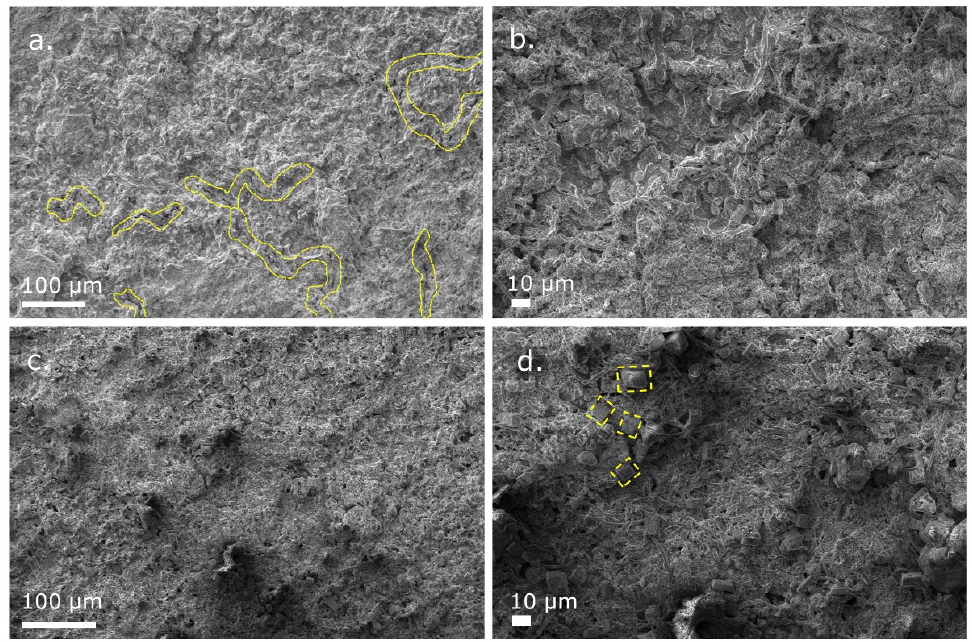
Figure 5. SEM micrographs of disassembled WS 2 /SiOC electrodes from ( a ) NIB half-cell; ( b ) NIB half-cell with a magnified view; ( c ) KIB half-cell; ( d ) KIB half-cell with a magnified view after 50 electrochemical cycles.